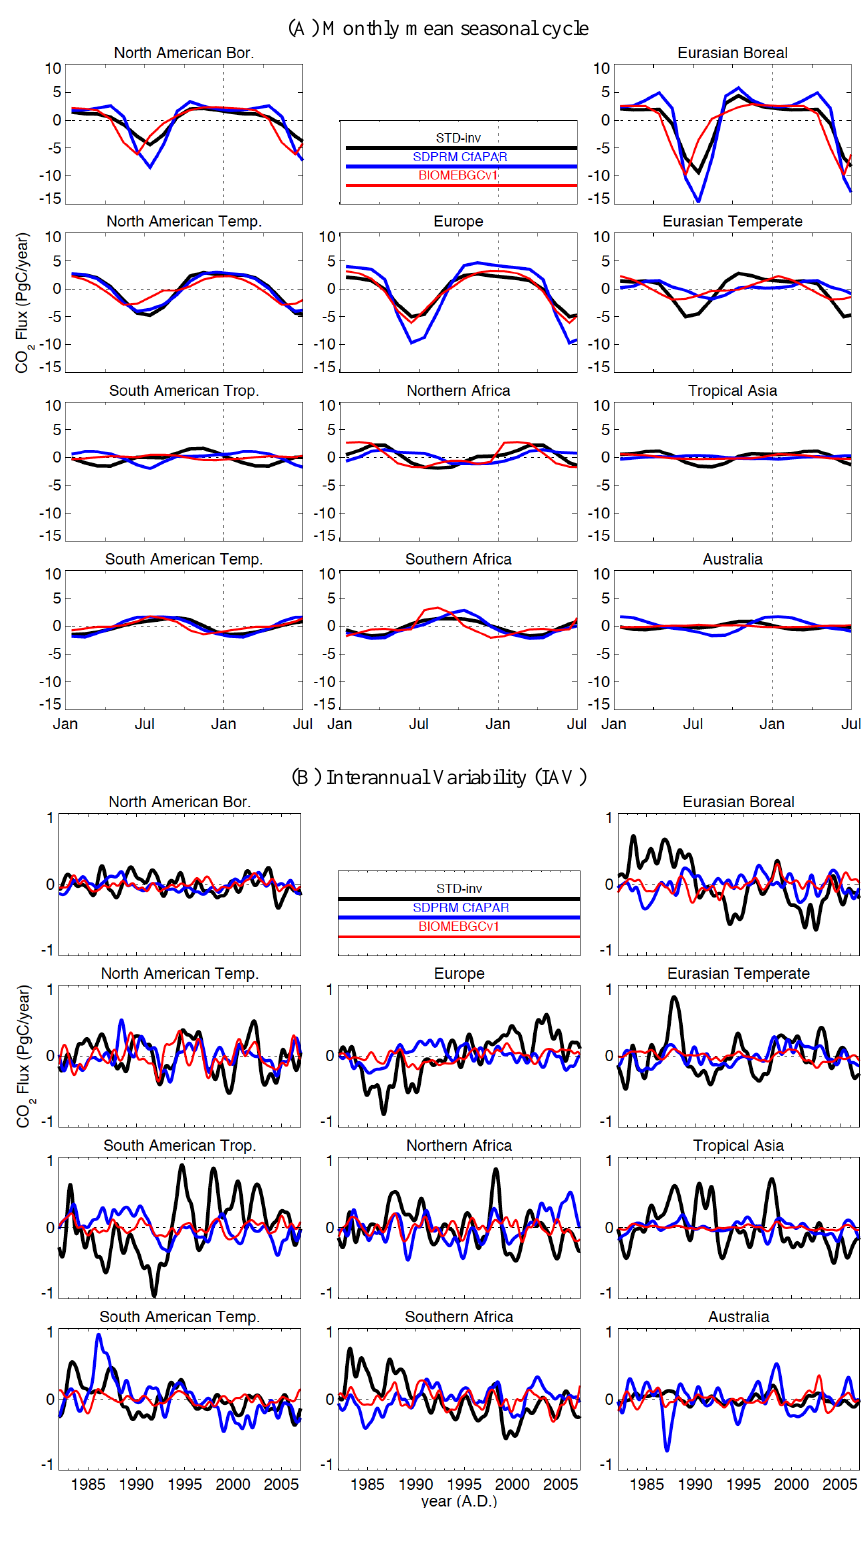
Fig. 7. The comparison between the estimated NEE from SDPRM-CfAPAR [Blue], BIOME-BGCv1 [Red] ,and the land flux estimated by STD-inv [Black] for the monthly mean seasonal cycle (A) and for the interannual variability (B) . The time series are integrated over 11 land regions (for the map of the regions see Fig. 3) and de-seasonalized and filtered for interannual variability (as in Rödenbeck (2005)). The fossil fuel emissions have been subtracted from STD-inv